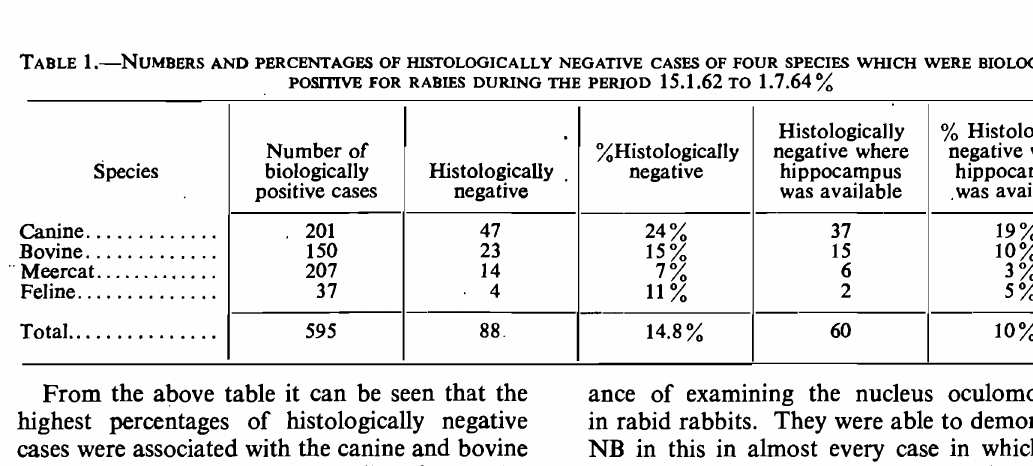
Number of Species biologically Histologically . positive